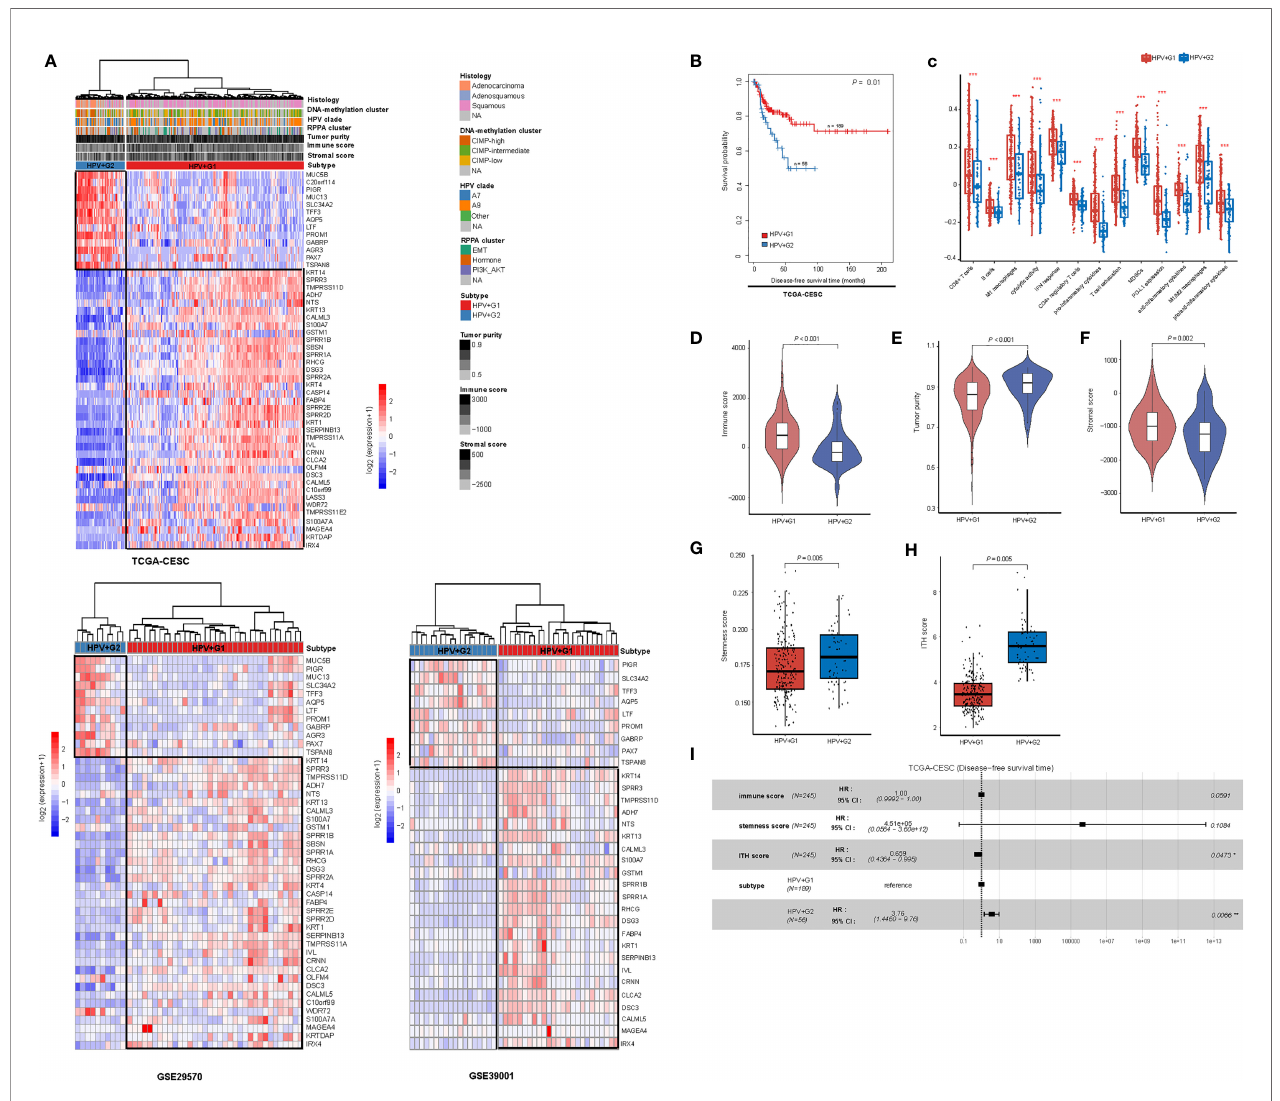
FIGURE 1 | Subtyping of HPV+ cervical cancers based on gene expression pro fi les. (A) Based on the expression levels of the 50 genes having the largest expression variations across the TCGA HPV+ cervical cancers, hierarchical clustering analyses identify two subtypes of HPV+ cervical cancers: HPV+G1 and HPV+G2, consistently in three different datasets. (B) HPV+G1 showing signi fi cantly higher disease-free survival rate than HPV+G2. The log-rank test P value is shown. (C) HPV+G1 showing signi fi cantly higher enrichment levels of various immune signatures than HPV+G2. The one-tailed Mann – Whitney U test or two-tailed Student ’ s t test P values are indicated. Comparisons of immune scores (D) , tumor purity (E) , stromal scores (F) , stemness scores (G) , and intratumor heterogeneity (ITH) scores (H) between HPV+G1 and HPV+G2. The one-tailed Mann – Whitney U test P values are shown. (I) Cox proportional hazards regression analysis showing that the subtype HPV+G2 is a risk factor for disease-free survival prognosis in HPV+ cervical cancers after adjusting for tumor immune signatures, stemness, and ITH. HR, hazard ratio; CI, con fi dence interval; * P < 0.05, ** P < 0.01, *** P < 0.001 (they also apply to the following fi